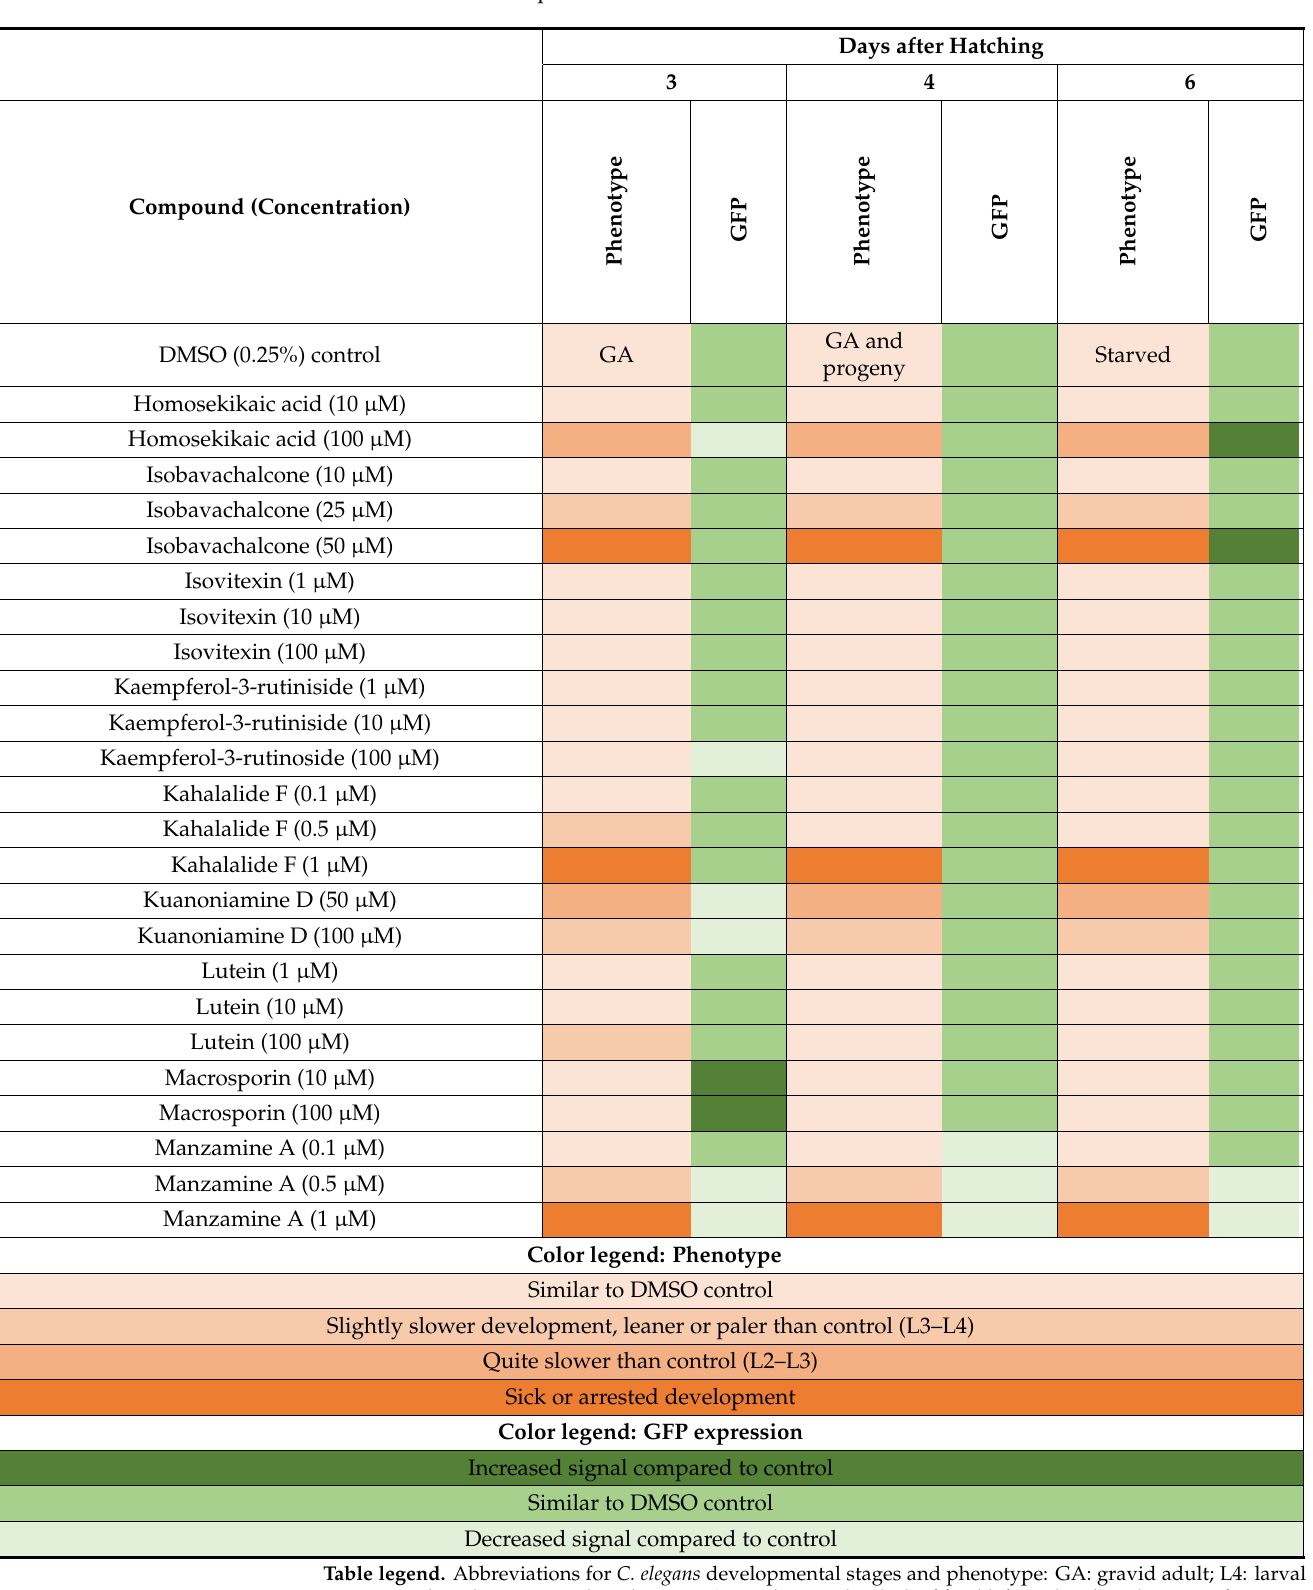
Table 1. Selected compounds on solid media.